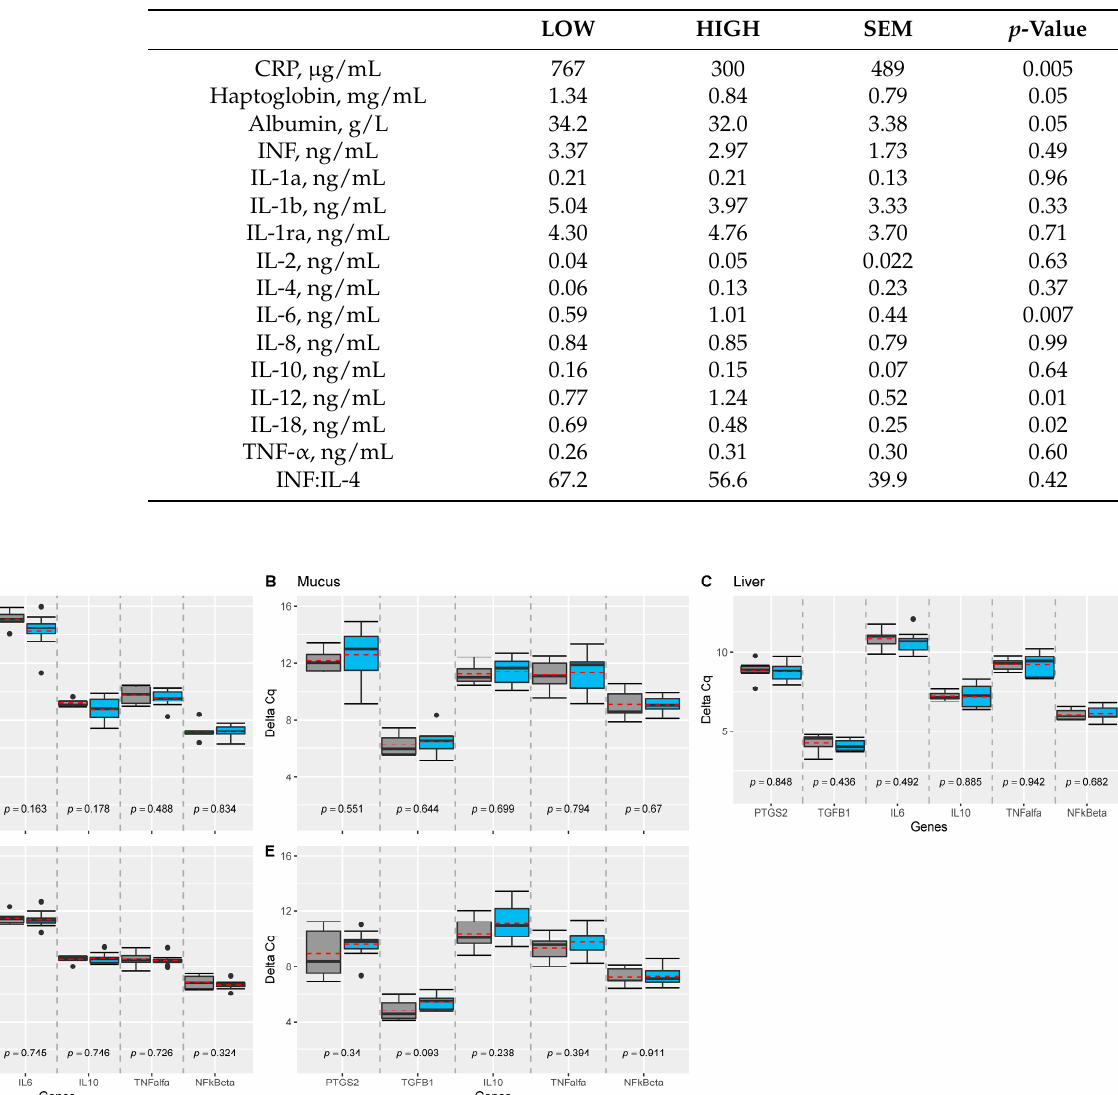
Table 5. Effect of maternal dietary antioxidant level on C-reactive protein (CRP), haptoglobin, albumin and cytokines (after LPS-stimulation) in plasma of off-springs at day 25 of age (LOW: n = 26 piglets; HIGH: n = 27 piglets; Mean and standard error of mean (SEM)).